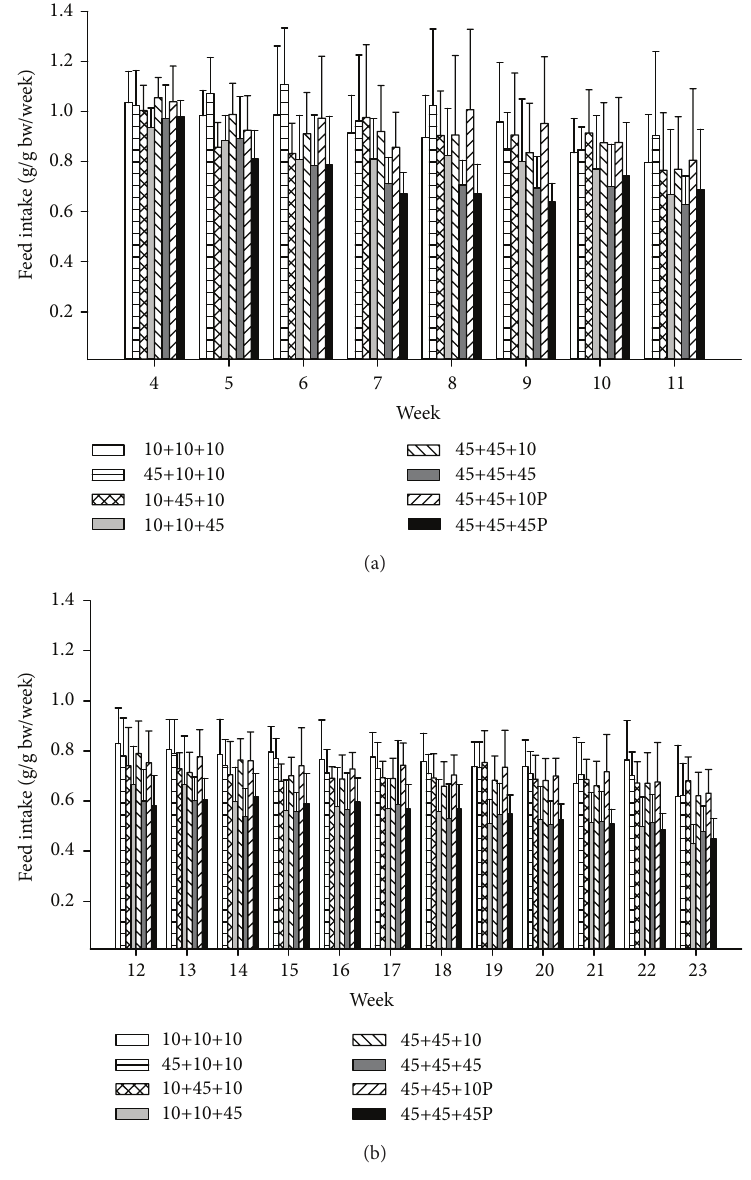
Figure 3: The feed intake of the mice offspring after weaning was recorded as gram diet per gram body weight per week (mean ± SD) for each experimental group ( 𝑛 = 10 – 27 ), shown for (a) female Min/+ and wild-type mice combined, from 4 to 11 weeks of age, and for (b) wild-type males, from 12 to 23 weeks of age. Experimental dietary groups: 10+10+10 (open white columns), 45+10+10 (horizontally striped columns), 10+45+10 (cross-hatched columns), 10+10+45 (light grey columns), 45+45+10 (left upwards diagonally striped columns), 45+45+45 (dark grey columns), 45+45+10 + PhIP (right upwards diagonally striped columns), 45+45+45 + PhIP (filled black columns), as explained in the legend to Figure